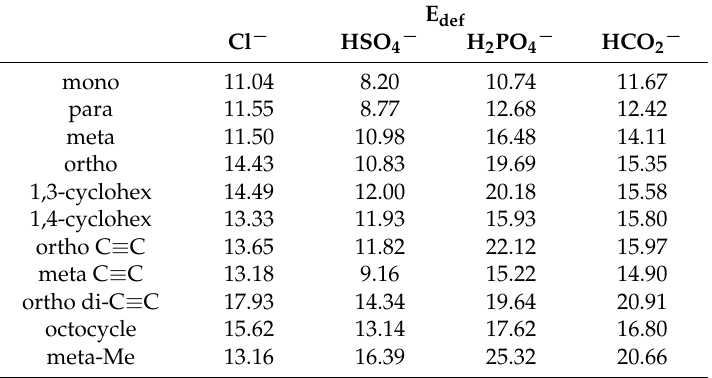
Table 3. Deformation energy (kcal/mol) required for optimized monomers to adapt to geometry within each complex.